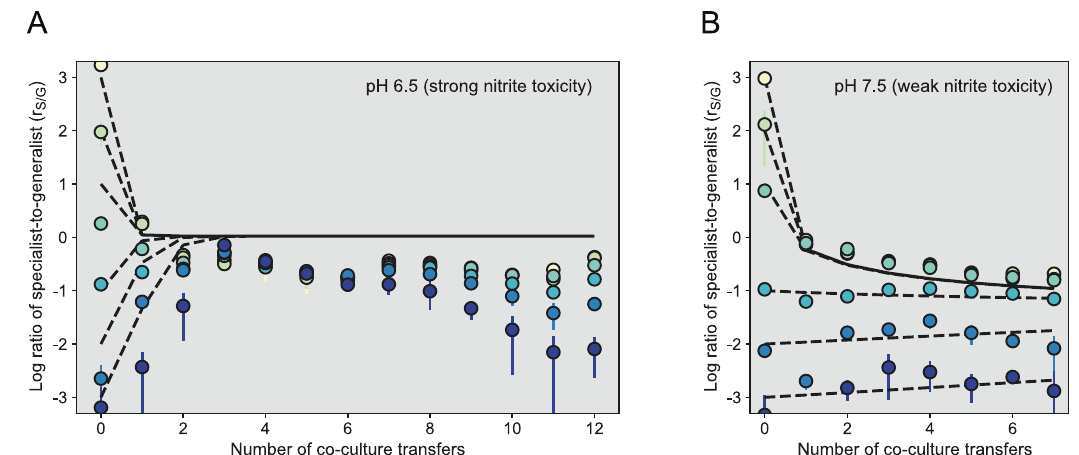
Fig. 4 Dynamics of r S/G during serial batch transfer. We mixed the generalist and specialist together at different initial r S/G s and grew them at A pH 6.5 (strong nitrite toxicity) or B pH 7.5 (weak nitrite toxicity) under anoxic conditions with nitrate as the growth-limiting substrate. We incubated the co-cultures until reaching the stationary phase and then diluted them 1:100 (vol:vol) into a fresh medium (referred to as a transfer). We measured the r S/G s using a spiral plating method in conjunction with fl uorescence photography immediately before each subsequent transfer. Data points are means and error bars are one standard error of two replicate experiments. Dashed lines are model simulations for co-cultures initiated at the same r S/G s used for the